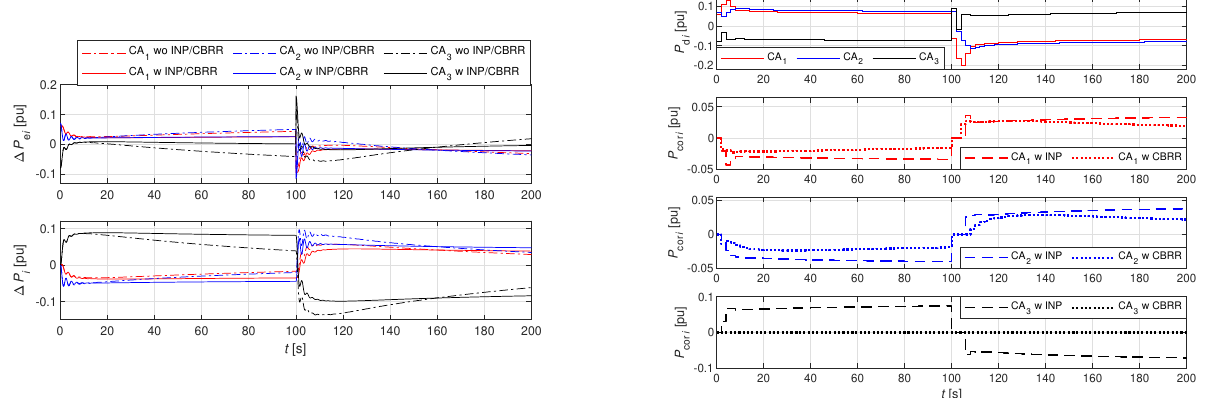
Figure 12. Time responses of ∆ P e i and ∆ P i ( left ) and time responses of P d i and P cor i ( right ) for a three-CA test system, where “wo INP/CBRR” is without and “w INP/CBRR” is with the INP and CBRR, whereas “w INP” is with the INP and “w CBRR” is with the CBRR.